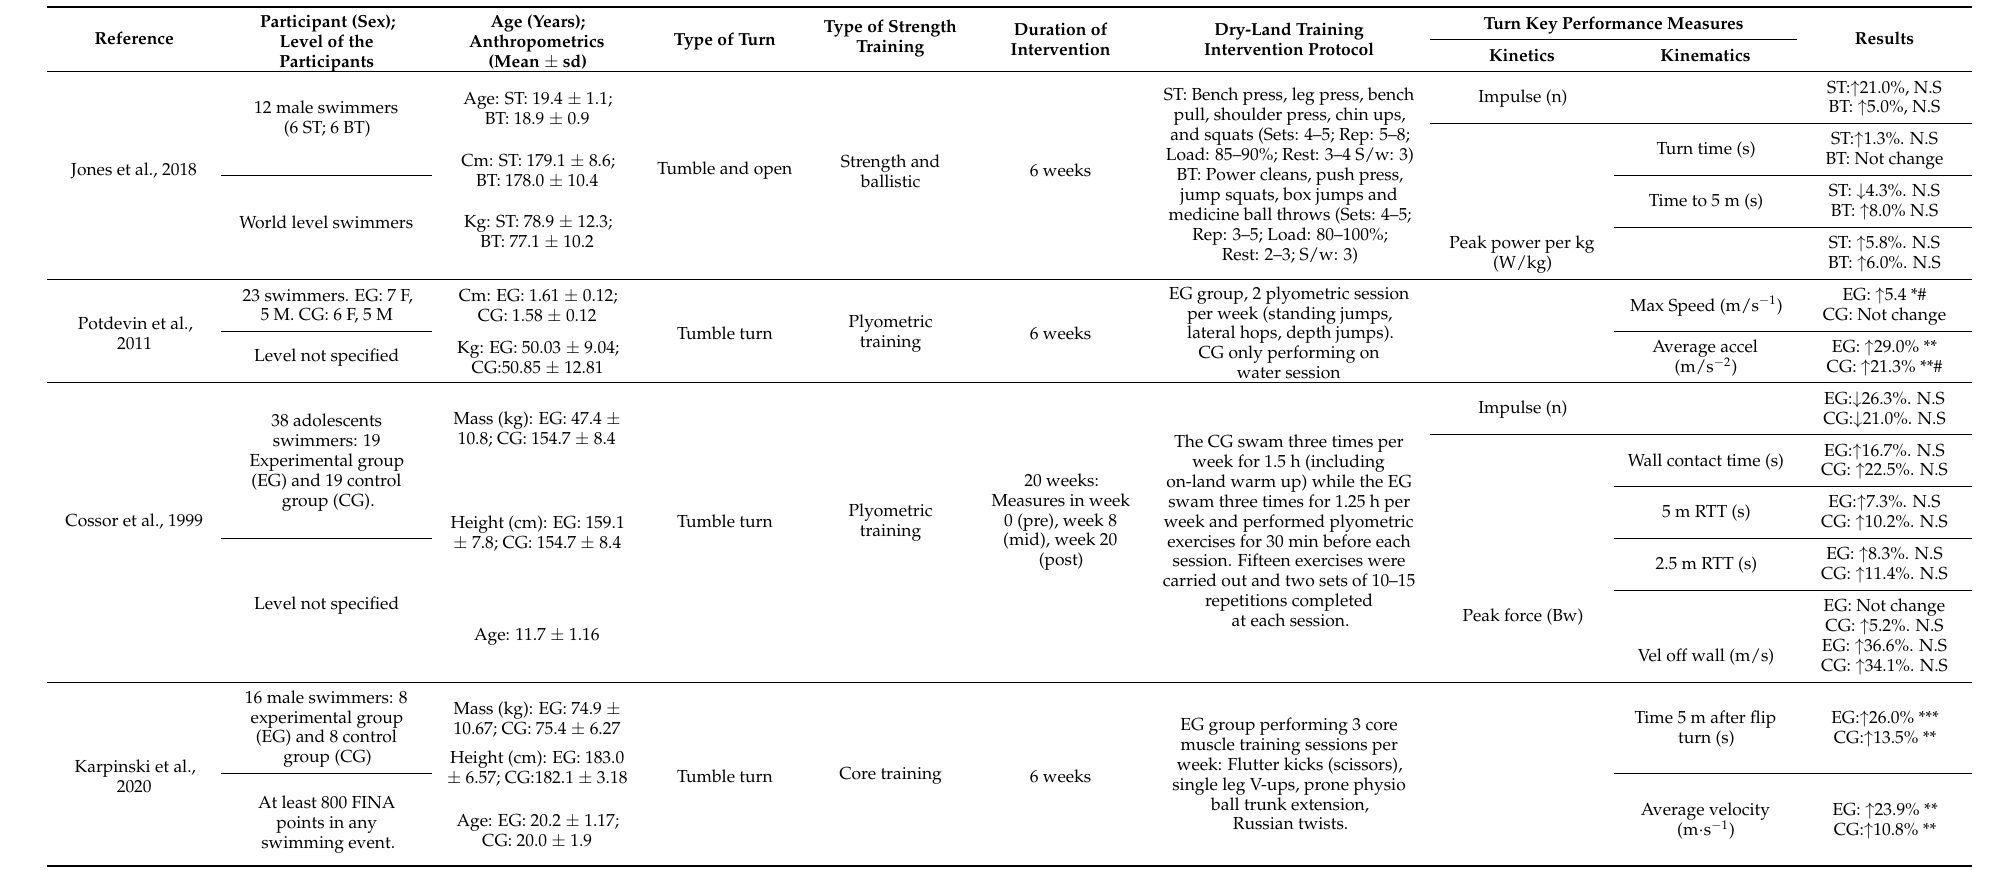
Table 3. Dry-land intervention studies carried out focusing on swimming turn